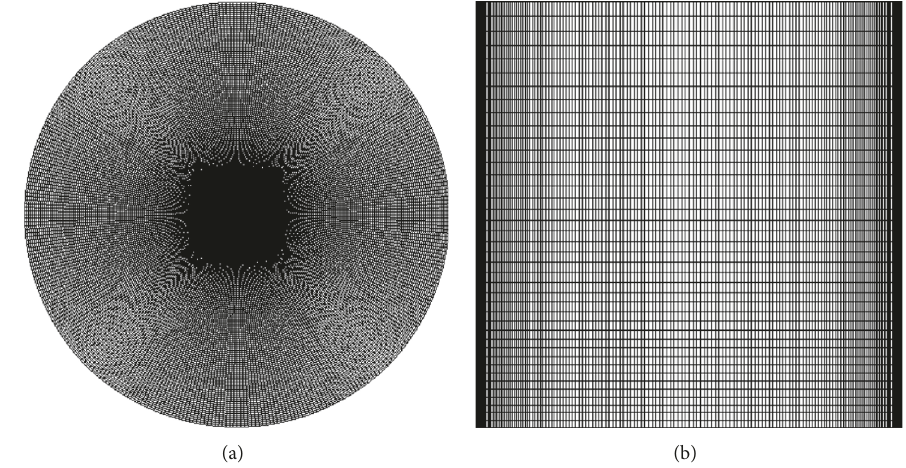
Figure 2: Coarse Mesh. (a) Top view; (b) side